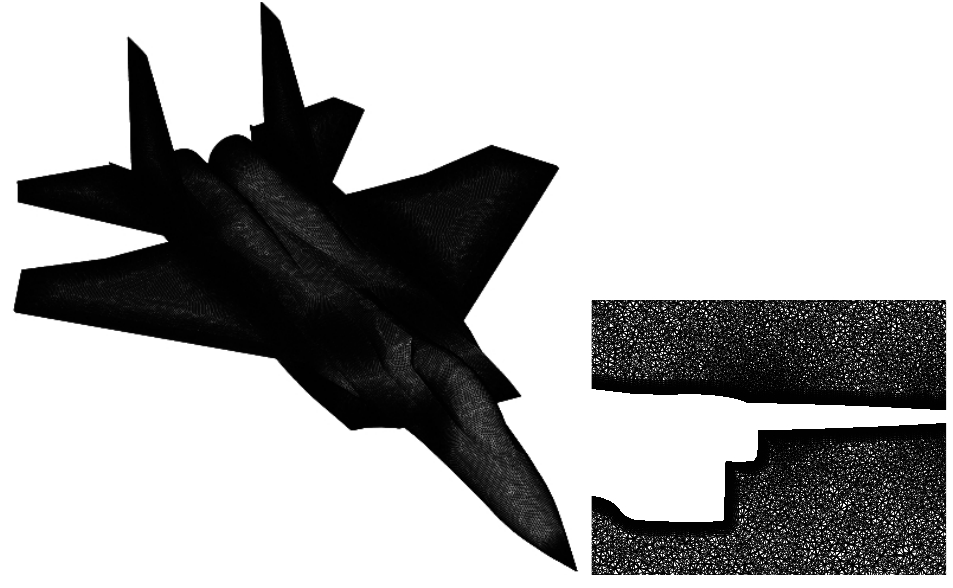
Figure 12. Surface mesh in the F15 aircraft configuration.